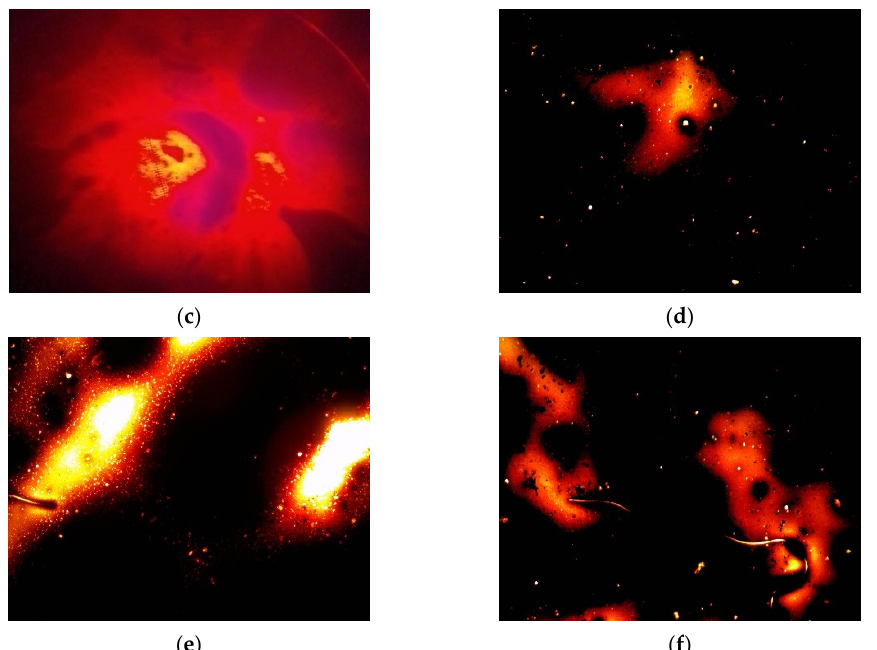
Figure 11. The micro-morphology of waste plastic/rubber-modified asphalt at various dosages of waste polyethylene: ( a ) 0% waste PE; ( b ) 2% waste PE; ( c ) 4% waste PE; ( d ) 6% waste PE; ( e ) 8% waste PE; ( f ) 10% waste PE.